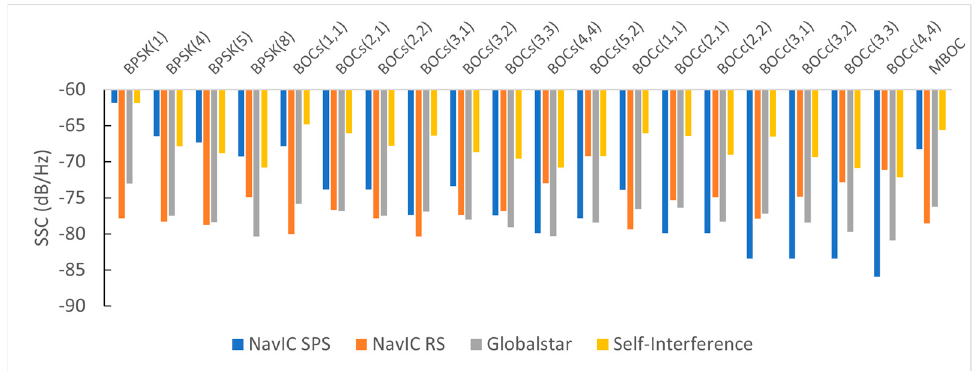
Figure 8. The SSC values between the existing S-band signals and each candidate. The spectral efficiencies for each candidate are shown in Figure 9. A high spectral efficiency indicated that the signal power distribution was concentrated within 16.5 MHz.